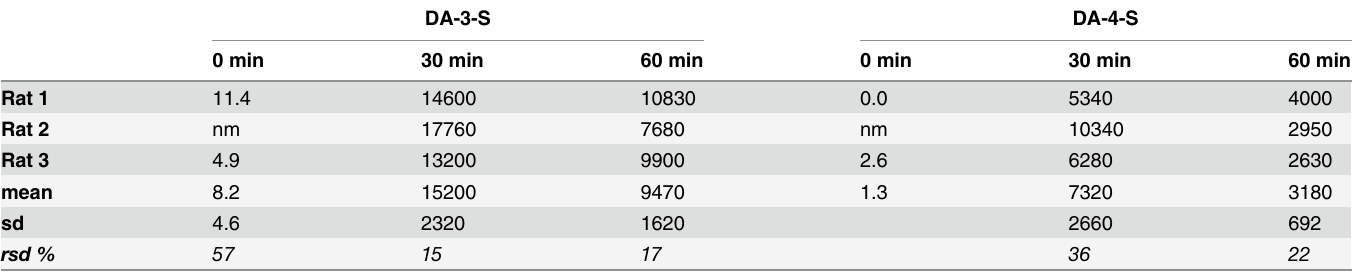
Table 3. Concentrations of DA-3-S and DA-4-S in plasma samples (nM) before (0 min) and after s.c. injections (30 and 60 min).